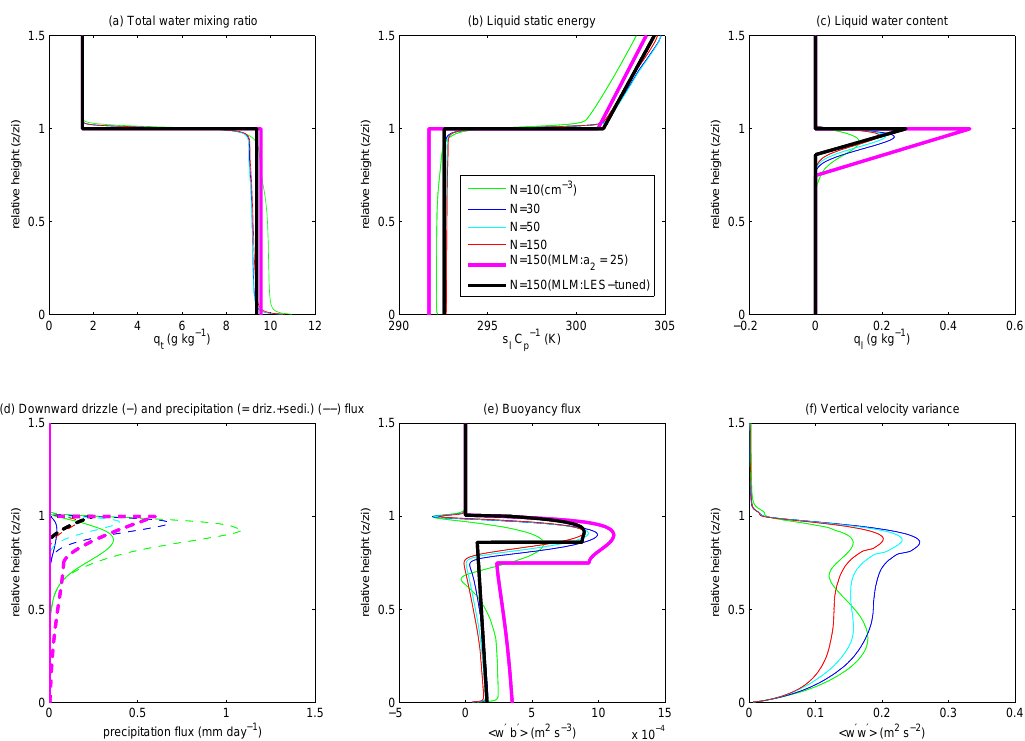
Fig. 2. LES profiles for N =10, 30, 50 and 150cm − 3 , averaged from 2–2.25 days and plotted against an inversion-normalized vertical coordinate: (a) q t , (b) s l , (c) liquid water content, (d) downward drizzle and precipitation (=drizzle + sedimentation) fluxes, (e) buoyancy flux, (f) vertical velocity variance. In (a)–(e) the thick curves show MLM results for N =150cm − 3 with the standard and LES-tuned entrainment closure for